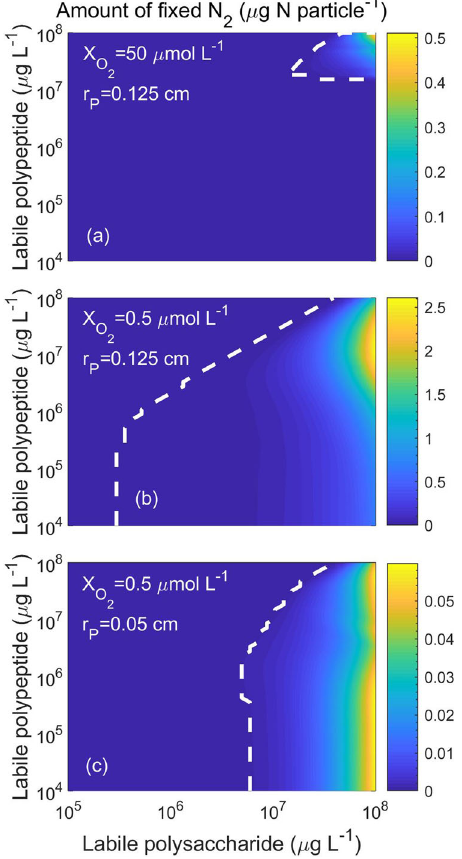
Fig. 5 The total amount of fi xed N 2 at different initial labile polysaccharide and polypeptide concentrations. N 2 fi xation is observed in a large particle of radius 0.125 cm and surrounding O 2 concentrations a 50 μ mol O 2 L − 1 and b 0.5 μ mol O 2 L − 1 , and c in a relatively smaller particle of radius 0.05 cm and surrounding O 2 concentrations 0.5 μ mol O 2 L − 1 . Line types are similar as in Fig. 4. Note the different ranges of the scale of N 2 fi